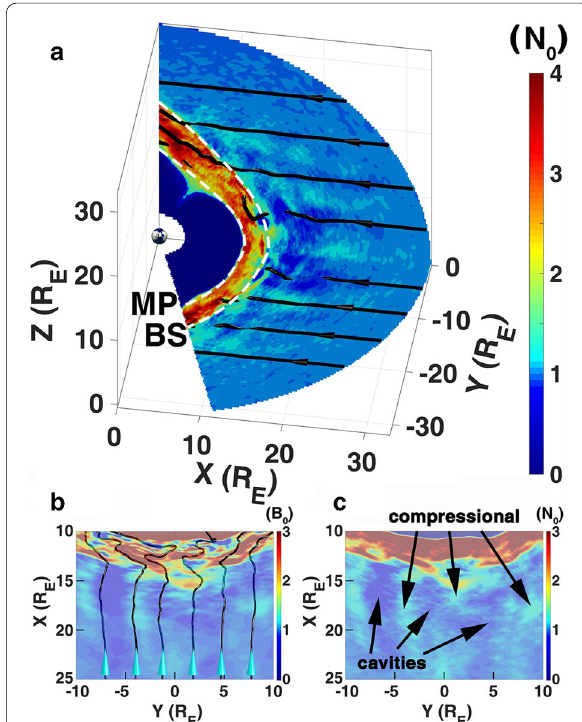
100 (cid:31) − 1 i 0 Fig. 1 Case I: spatial contours of ion density N at t = showing the 3-D structures of self-consistently generated global system. a Presents the global view of N in the noon-meridian and equatorial planes, and the Earth is also shown at the origin in our GSM coordinate system. The white dashed lines roughly mark the magnetopause and bow shock positions, respectively. b , c Give the zoom-in equatorial views of Q -|| foreshock. Typical magnetic field lines with arrows showing the field line direction are displayed in a and b . Note that the 3-D field lines in a are partly hidden by the contour planes which are completely opaque. The wiggled field lines in the foreshock region are caused by the ion foreshock disturbance. Typical foreshock cavities and compressional pressure pulses are illustrated in